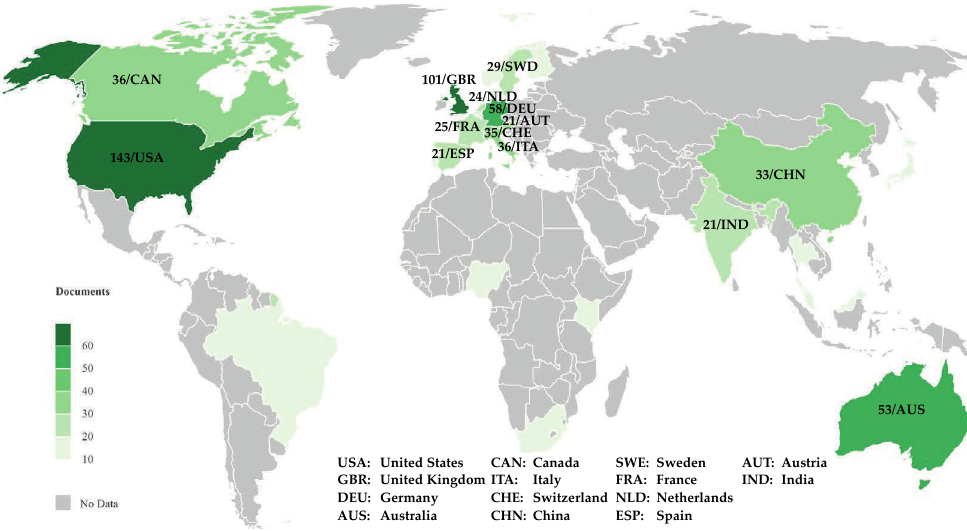
Fig. 1. Countries with the most authors’ institutional